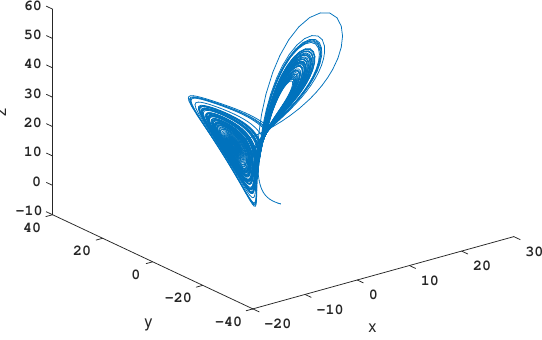
Figure 1. The chaos diagram of Lorenz’s system at initial condition x 0 = [ 5,1, − 3 ] T